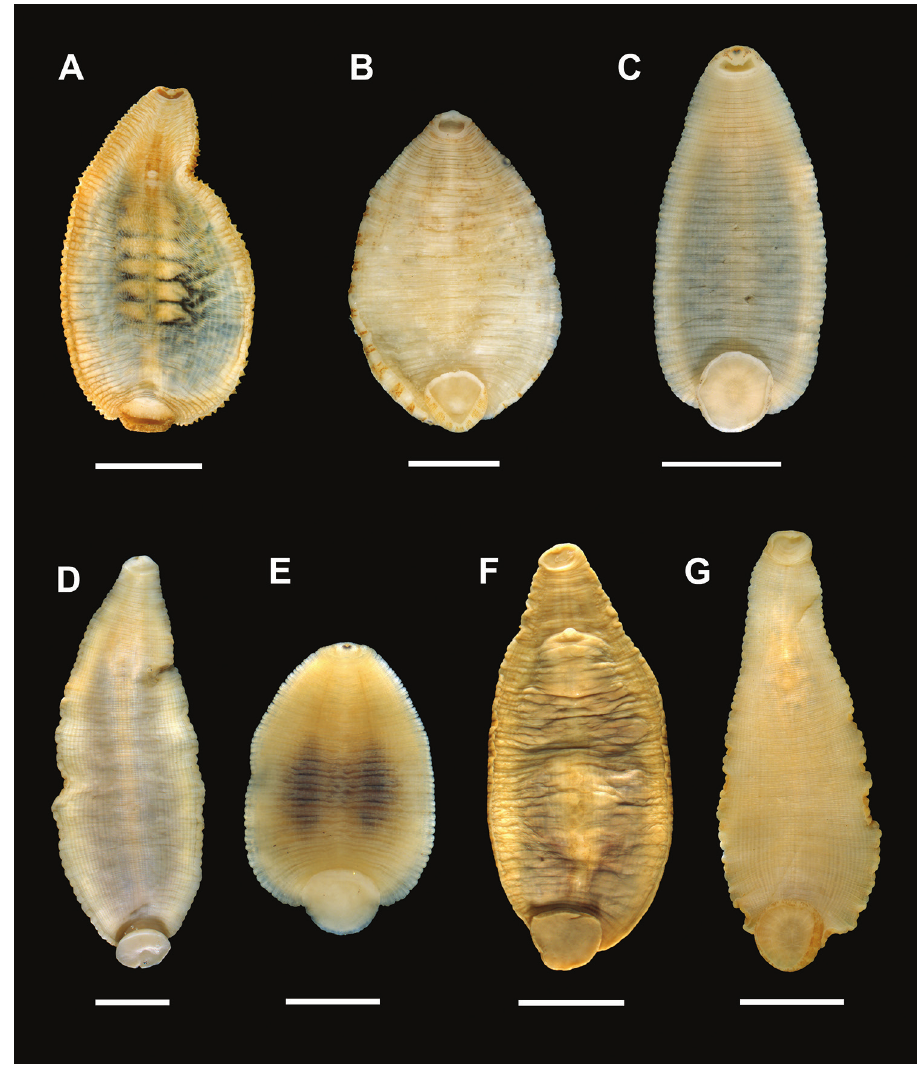
Figure 6. Ventral surface of various species of Placobdella . Note the diameter of the caudal sucker relative to body length and width of individuals. A Placobdella ali (YPM IZ 058279) B Placobdella ornata (YPM IZ 083847) C Placobdella siddalli Richardson & Moser (YPM IZ 083857) D Placobdella multilineata (YPM IZ 083850) E Placobdella papillifera (YPM IZ 083856) F Placobdella parasitica (YPM IZ 059092) G Placobdella rugosa (YPM IZ 056680). Scale bars: 10 mm ( A, F ), 2 mm ( B ), 3 mm ( C ), 5 mm ( D, G ), 1 mm ( E